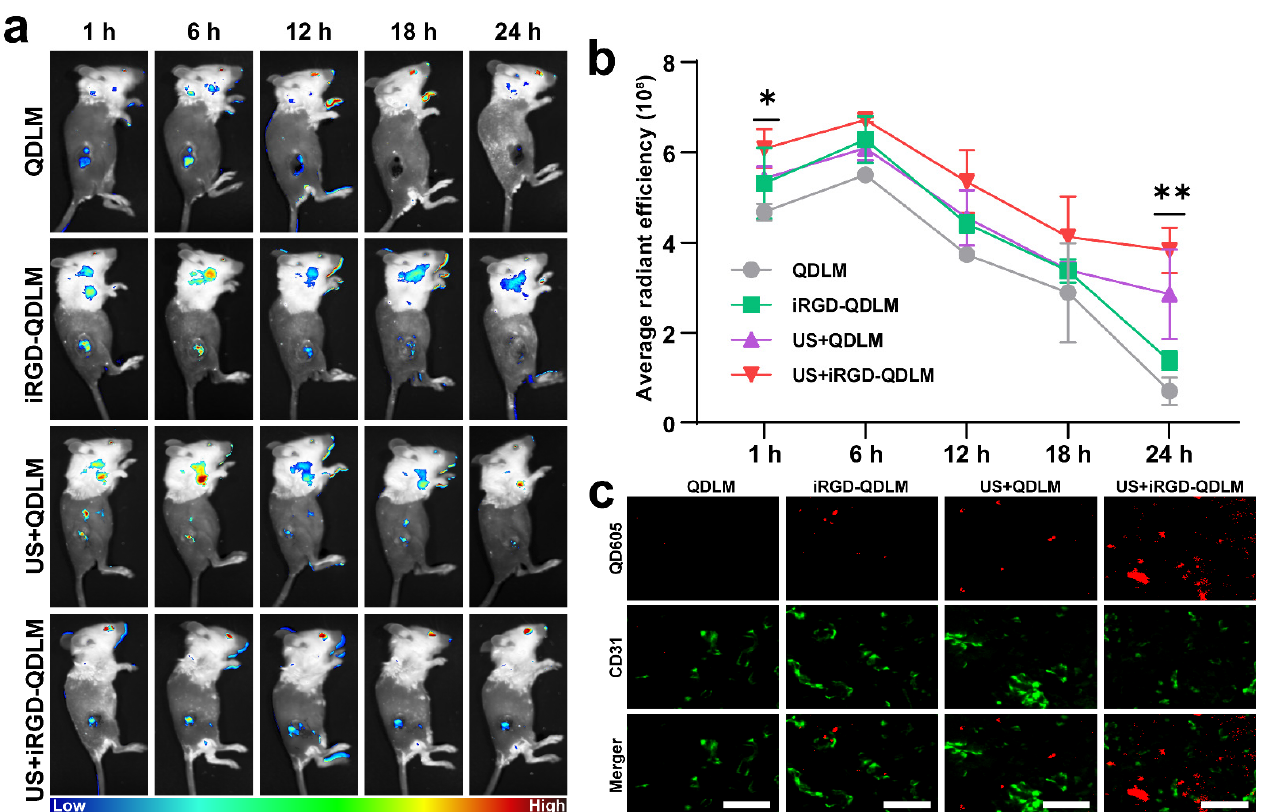
Figure 5. In vivo transvascular fluorescent imaging of iRGD-QDLM in the tumors. ( a ) In vivo fluorescent imaging of the tumor-bearing mice treated with QDLM, iRGD-QDLM, US + QDLM, and US + iRGD-QDLM. n = 5 mice in all groups. ( b ) Quantitative analysis of the average signal intensities in the brain after treatment with QDLM, iRGD-QDLM, US + QDLM, and US + iRGD-QDLM at different times. * p < 0.05 vs. control, ** p < 0.01 vs. control. ( c ) Confocal images of the tumor slices stained by anti-CD31 (green) after 24 h post treatment of QDLM, iRGD-QDLM, US + QDLM, and US + iRGD-QDLM. Red color represents QD605. Scale bar: 20 µ